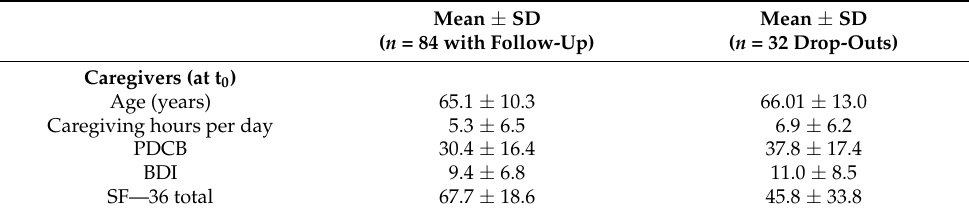
Table A1. Comparison of baseline data of the dropouts with baseline date of the caregiver with completed follow-up.